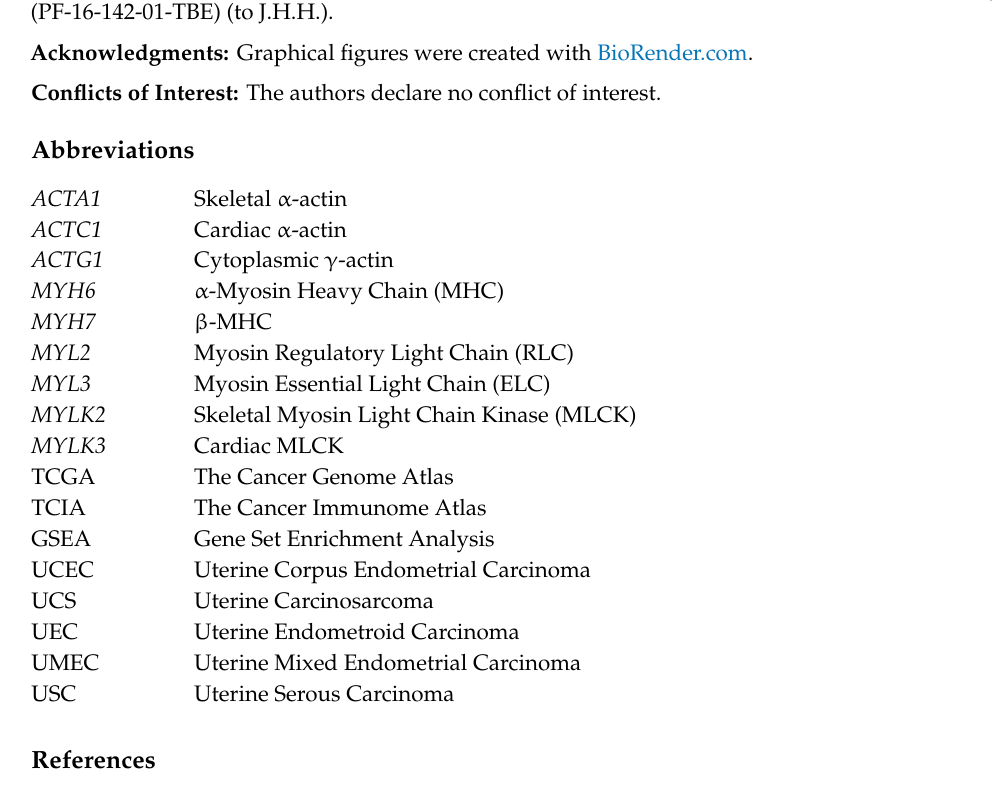
s1. Figure S1. Genomic alterations of actomyosin genes in Pan-Cancer analysis. Figure S2. Genomic alterations of putative tumor promoting and suppressing genes. Figure S3. Genomic alterations of MYH6 and MYH7 . Figure S4. Genomic amplifications of key actomyosin genes in the same locus. Figure S5. Overall survival of patients with NPLOC4 in uterine cancer patients. Table S1. Nine actomyosin genes and their genomic locations. Table